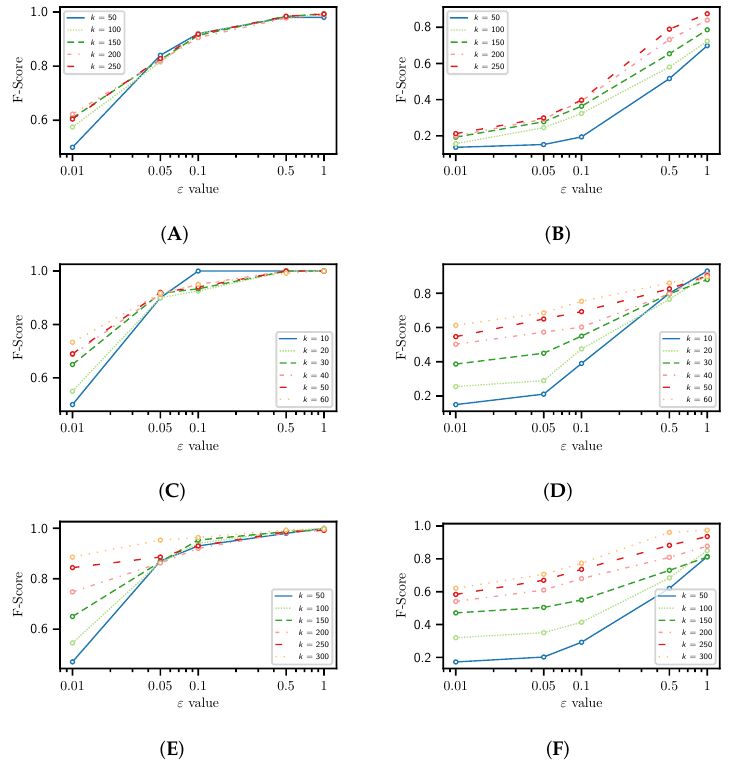
Figure 4. Utility measures using the F-score for DP-FSM and Graph-based applied to different dataset. Where ( A ) DP-FSM Bank, ( B ) Graph-based Bank, ( C ) DP-FSM German, ( D ) Graph-based German, ( E ) DP-FSM NYC, and ( F ) Graph-based